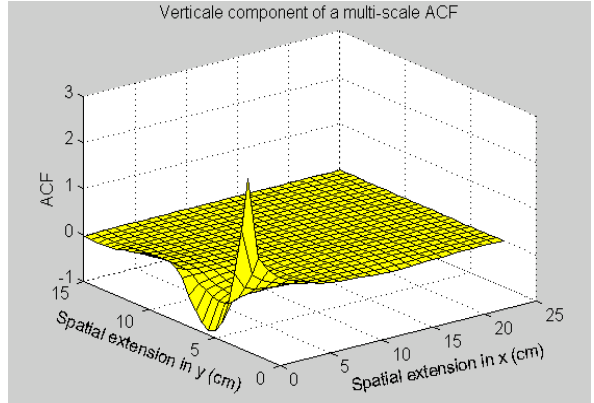
Figure 1. Vertical component of a MLS two-dimensional